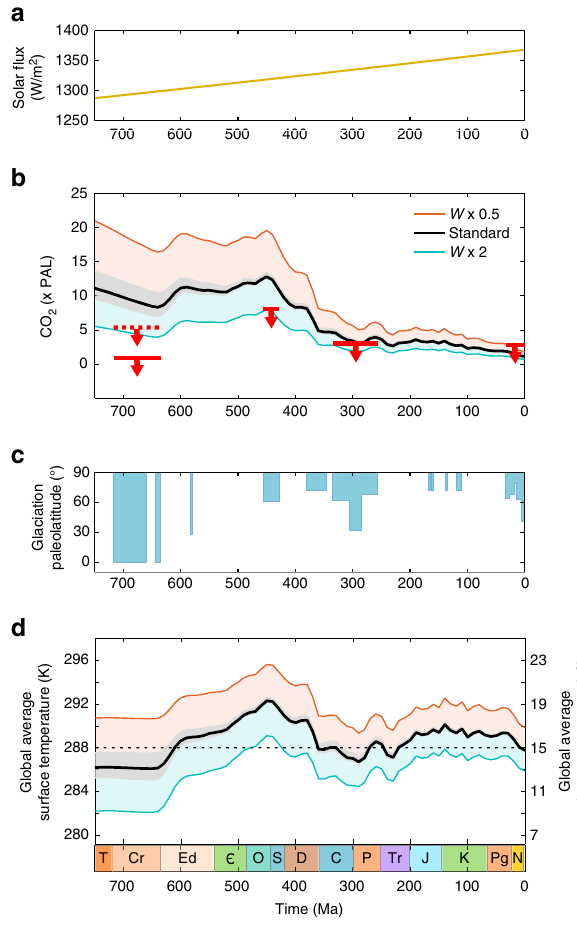
Fig. 4 Model predictions. Model of Mills et al. (ref. 40 ), with relative degassing rate set proportional to PALEOMAP subduction zone length. a Model solar fl ux. b Relative atmospheric CO 2 concentration shown against suggested thresholds for glaciation (red bars, see text). c Glaciation paleolatitude, as in Fig. 1. d Modelled global average surface temperature. For model runs, black lines show standard run, as in the COPSE model (see text), blue lines show twofold enhancement of terrestrial weathering ( W = 2), representing a lower bound under potential glaciation trigger events. Orange lines show a twofold suppression of weathering rates ( W = 0.5)